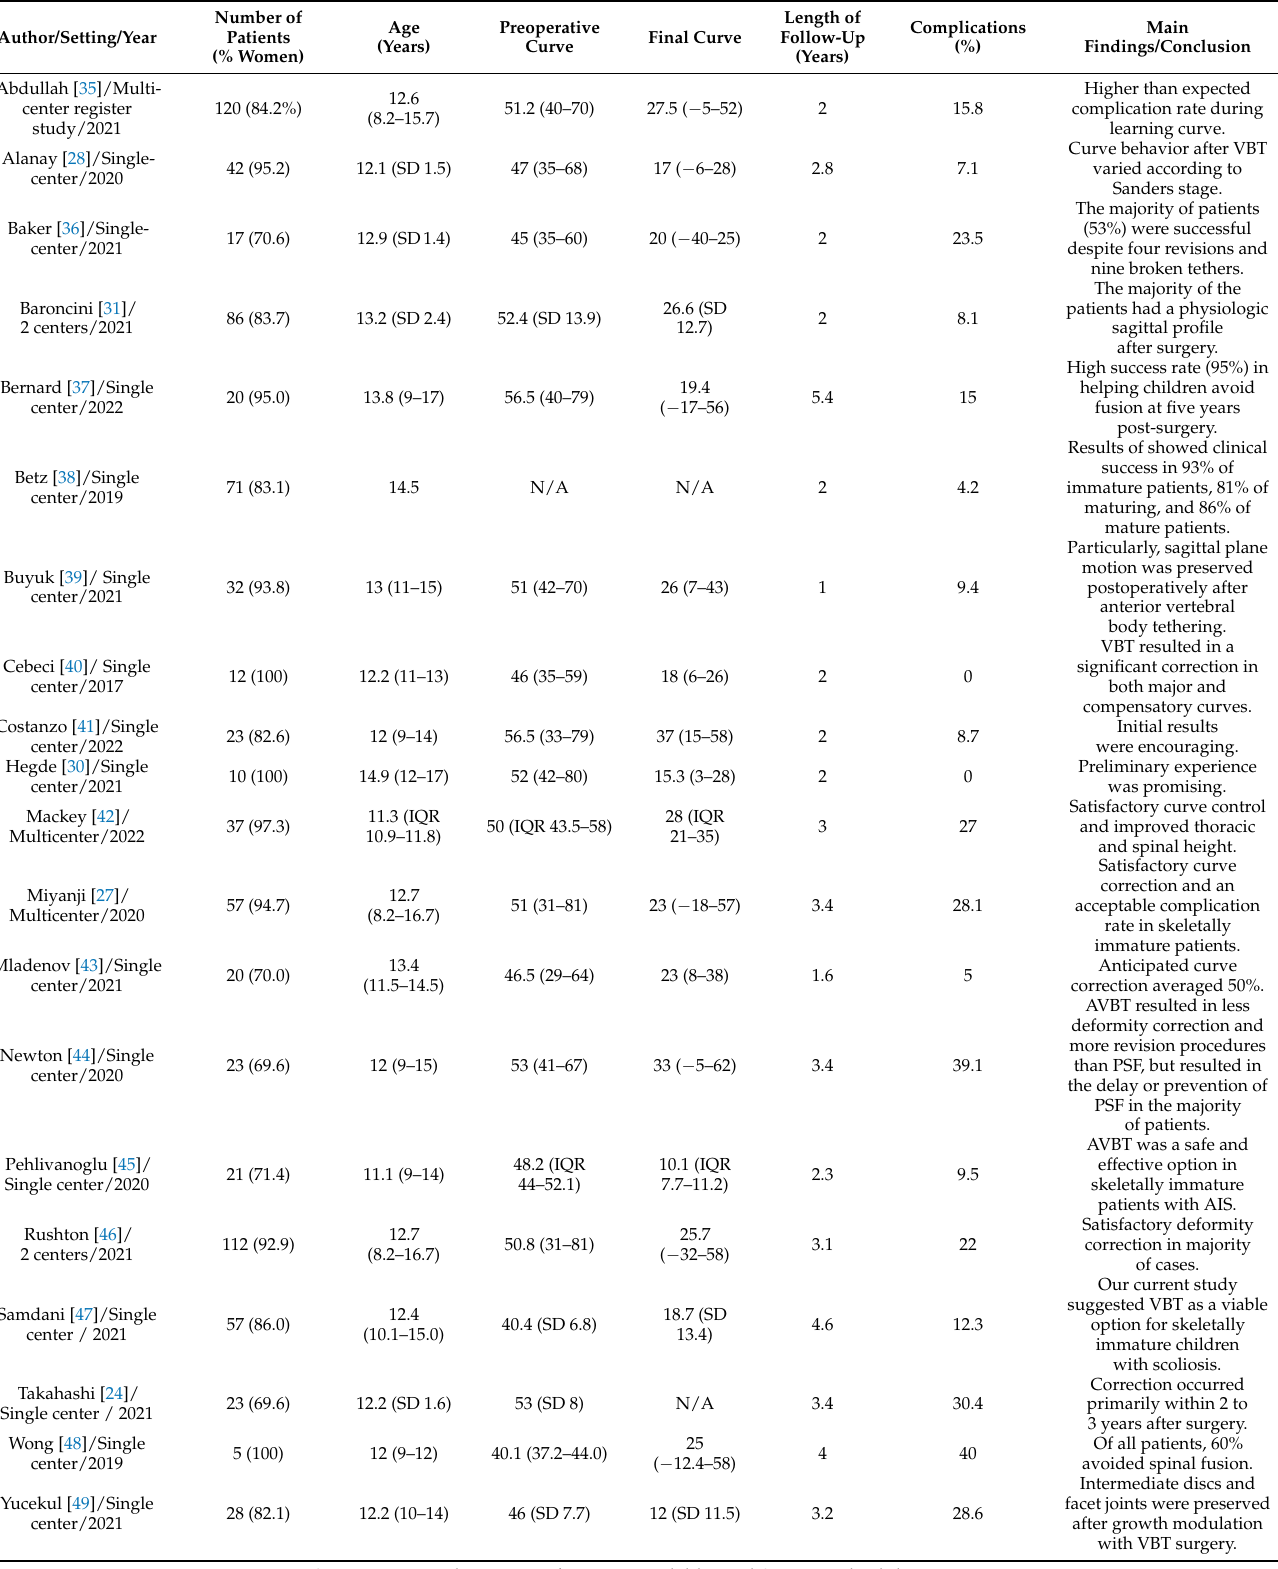
Table 1. Summary of eligible studies and their main findings. Values are given as mean (range) unless mentioned